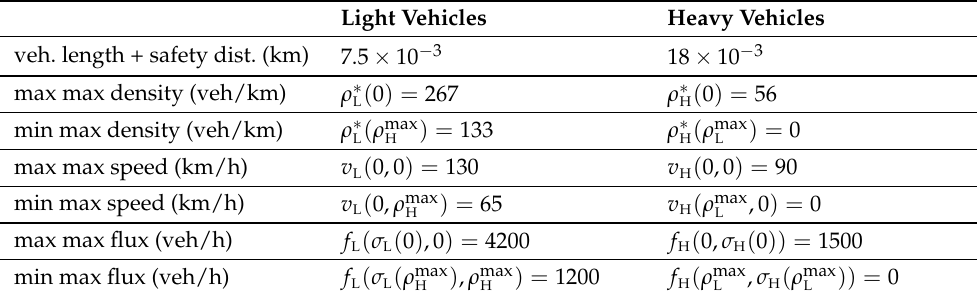
Table 1. Parameters for the macroscopic